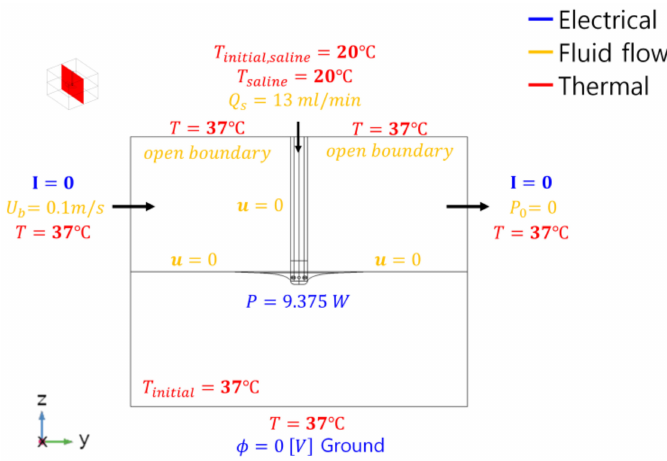
Figure 5. Boundary conditions of the heat transfer model of the heart